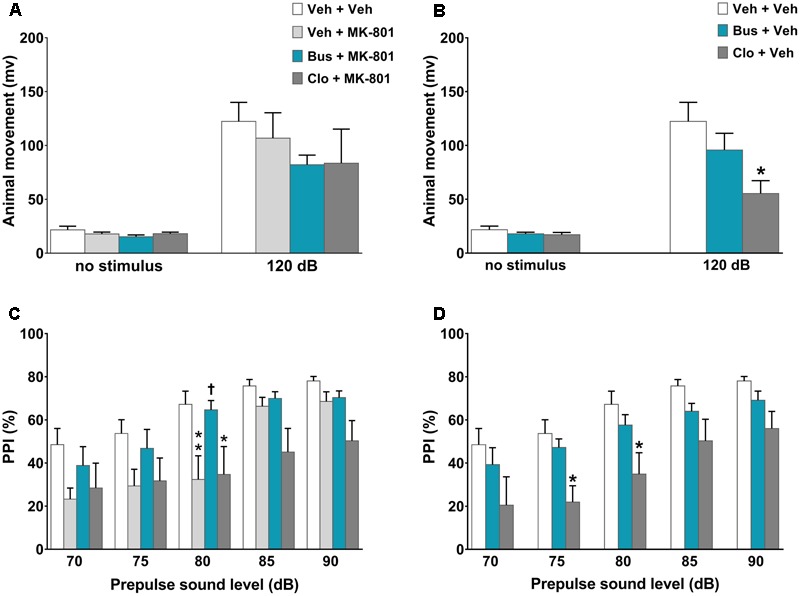
Buspirone blocked MK-801-induced PPI disruption in WT mice. Buspirone (Bus, 3 mg⋅kg-1, i.p.) or vehicle (Veh), clozapine (Clo, 1 mg⋅kg-1, i.p.) or Veh and MK-801 (0.1 mg⋅kg-1, i.p.) or Veh were injected 45, 30, and 20 min before the PPI test, respectively. (A,B) Animal movements displayed by Veh + Veh (n = 10), Veh + MK-801 (n = 10), Bus + MK-801 (n = 9), Clo + MK-801 (n = 8), Bus + Veh (n = 13), Clo + Veh (n = 8) WT mice. (C,D) PPI% displayed by the same WT mice. Data are shown as mean ± SEM. ∗∗p < 0.01,∗p < 0.05 vs. Veh + Veh WT mice; †p < 0.05 vs. Veh + MK-801 WT mice; (Two-way ANOVA with or without repeated-measures and Newman–Keuls post hoc test).